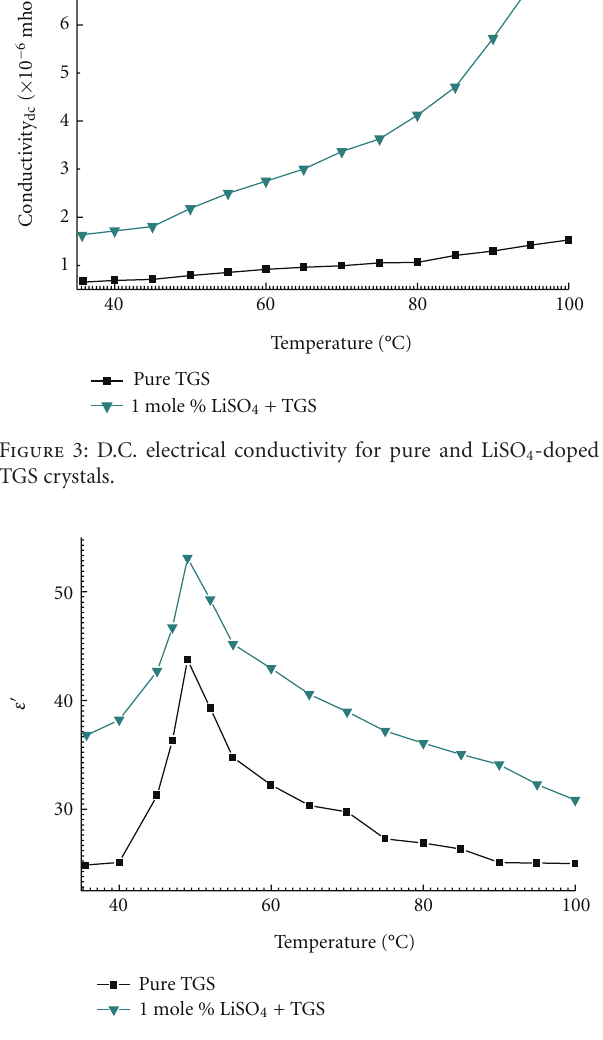
Figure 4: Graph for dielectric constant versus temperature of pure TGS and LiSO 4 -doped TGS crystals.